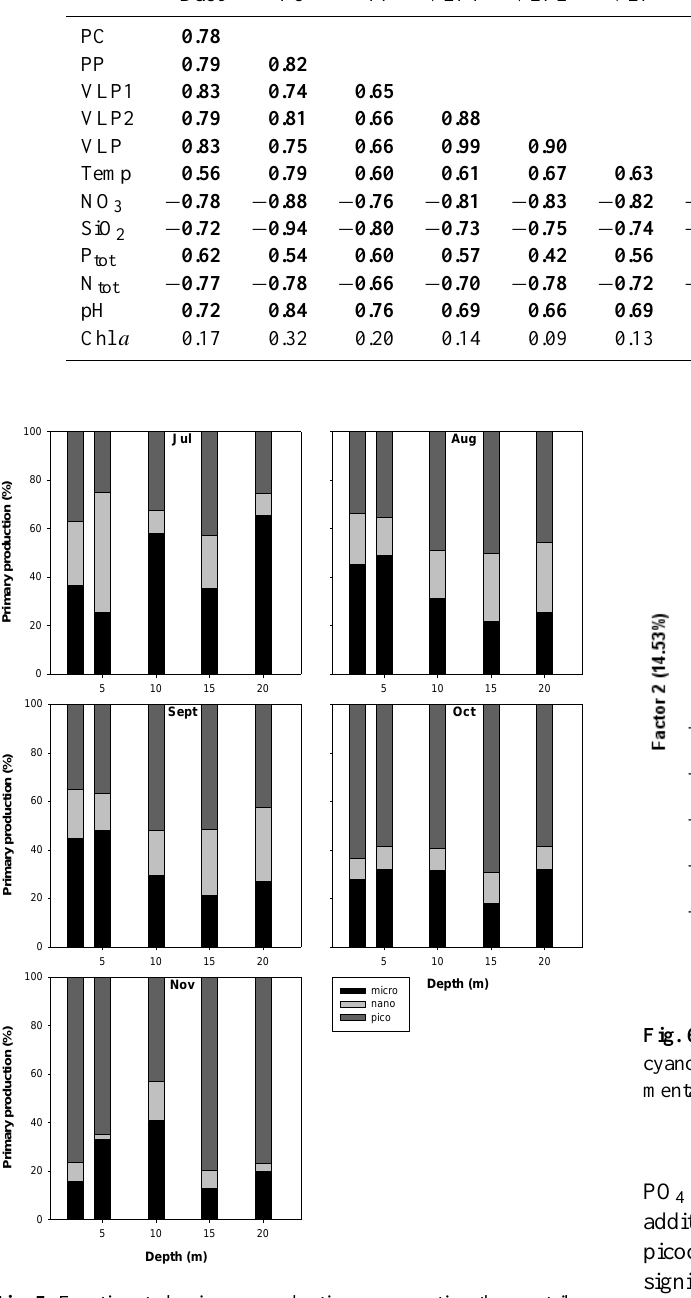
Fig. 5. Fractionated primary production representing the contribution of the various size fractions of the phytoplankton (i.e. the pico-, nano and microphytoplankton) at the different periods sampled.